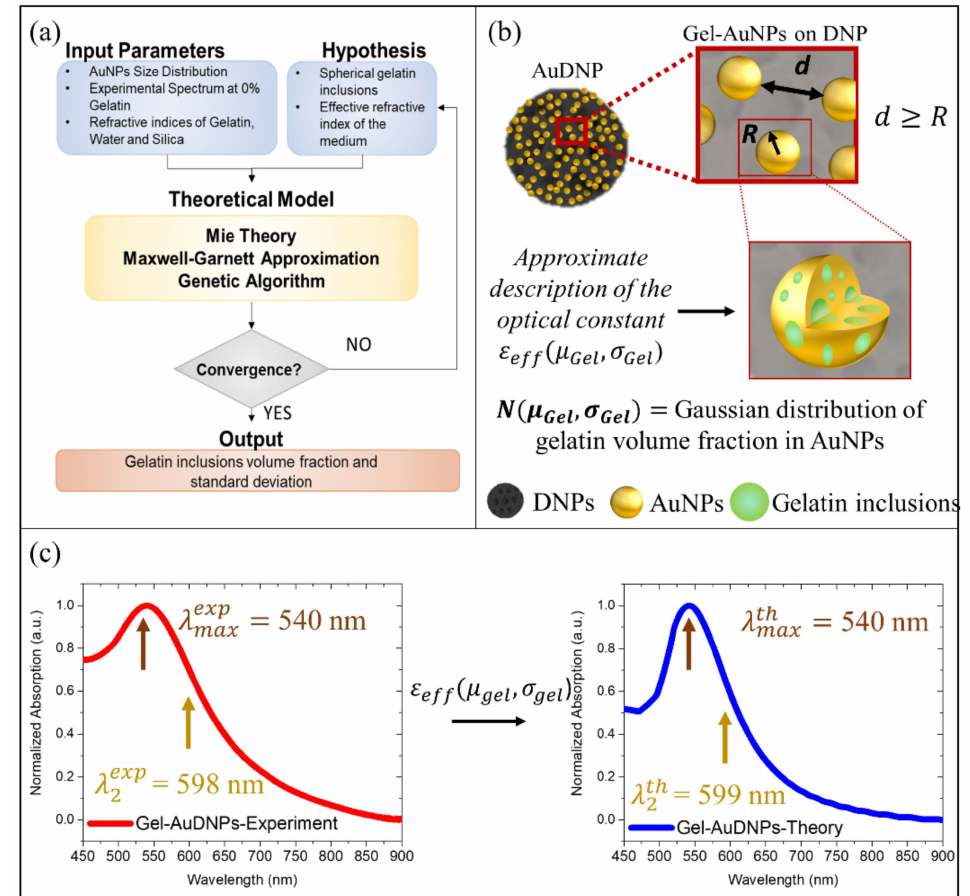
Figure 2. Reverse engineering problem: ( a ) Schematics of the combined theoretical and experimental approach followed to derive the volume fraction of the gelatin inclusions. ( b ) Schematics showing the approximations followed in the optical description of hybrid gel-AuNPs. ( c ) The normalized experimental absorption spectrum of Gel-AuDNPs with no gelatin shells (red line) having LSPR λ 2 = 540 nm and inflexion point λ 2 = 598 nm; normalized theoretical absorption spectrum of gel-AuDNPs with no gelatin shells obtained by the application of the parameters µ gel = 0.11 and σ gel = 0.03 (blue line). The minimized root mean square between theoretical and experimental spectra is